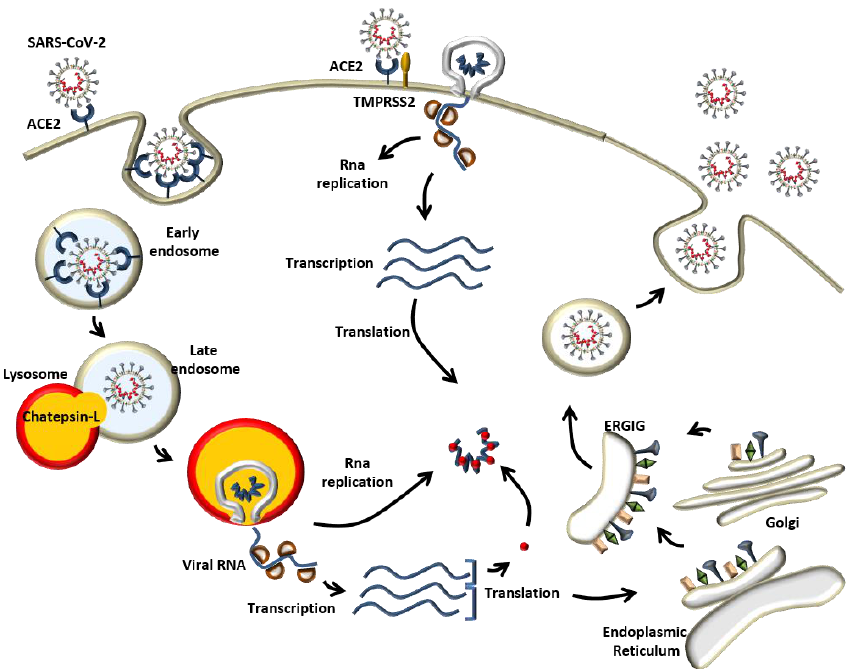
Figure 3. Mechanism of infection. SARS-CoV-2 recognizes the host cell by binding with the Angiotensin- converting enzyme 2 (ACE2) via Spike glycoprotein S1 unit. The priming of the Spike glycoprotein can be mediated by the TMPRSS2 protease that allows virus/membrane fusion guided by the S2 unit. Alternatively, the virus can enter the cell by using the endocytic pathway where Chatepsin-L cleaves the S protein allowing also in this case the priming of the late endosome membrane with the S2 unit. The viral RNA will undergo transcription and replication. The new viral particle will be built in the ER-Golgi intermediate compartment (ERGIC) and released by exocytosis.